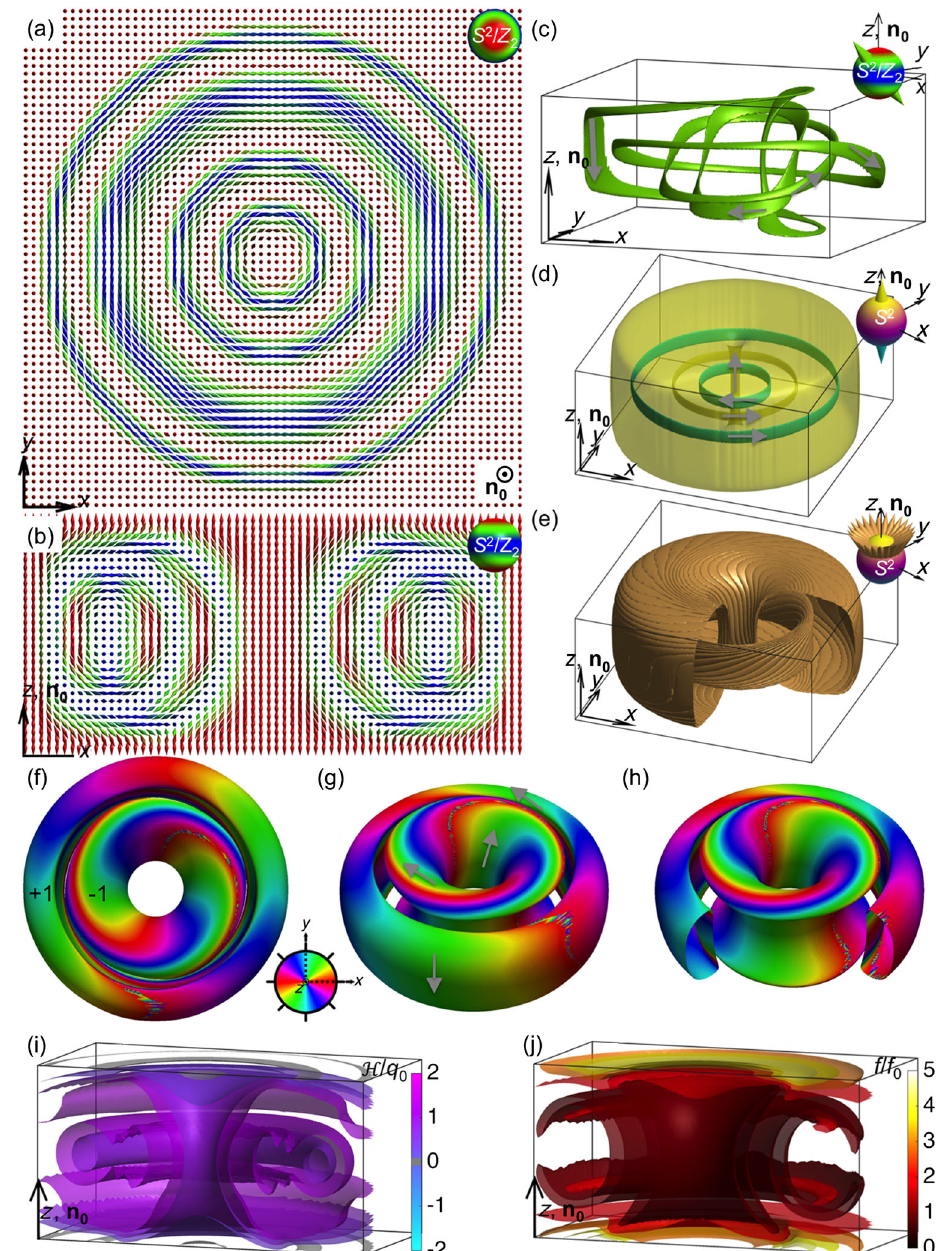
FIG. 8. 3D soliton with complex linking and 4 π twist from its central axis to the far-field periphery. (a),(b) Computer-simulated (a) in-plane and (b) vertical cross sections of the axially symmetric n ð r Þ structure of the 3D soliton depicted using double cones and the color scheme that establishes correspondence between director orientations and the points on S 2 =Z 2 (top right insets). (c) A representative computer-simulated preimage of the hopfion for the diametrically opposite points on S 2 =Z 2 marked by double cones in the top right inset. The preimage is composed of four interlinked closed loops. (d), (e) Computer-simulated preimages of the 3D soliton in a vectorized n ð r Þ (d) for two diametrically opposite points on S 2 corresponding to its north and south poles (top right inset) and (e) for a set of points characterized by a constant polar angle θ and forming a circle parallel to the sphere ’ s equator (top right inset). Note that the preimages in (e) reside on two nested tori surfaces. A large variety of preimages of this soliton are shown in Video 2. (f) – (h) Three representative views on the isosurfaces of θ ¼ π = 2 ( n z ¼ 0 ) colored by azimuthal orientations of n ð r Þ according to the scheme shown in the right-hand side inset of (f). The numbers on top of the tori shown in (f) indicate the linking numbers that characterize the interlinking of colored closed-loop bands and preimages of n ð r Þ corresponding to points on the equator of S 2 =Z 2 . (i),(j) Perspective views of the 3D computer-simulated isosurfaces of normalized (i) handedness and (j) free-energy density for this axially symmetric 3D soliton, with the corresponding color schemes shown in the right-hand side insets. Gray arrows in (c) and (d) and on the green bands of (g) indicate the consistently determined circulations of the preimages. Computer simulations are performed for elastic constants of ZLI-2806 and d=p ¼ 2